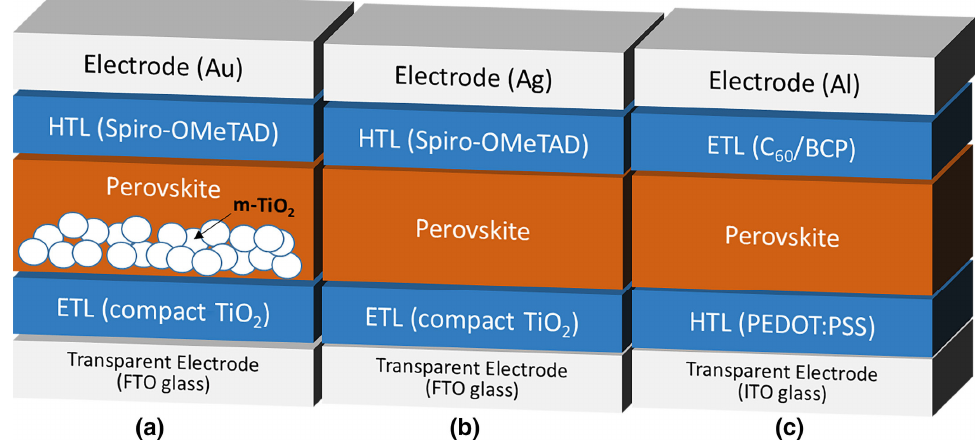
Figure 8. Device architectures for ( a ) mesoporous perovskite solar cell of the normal structure, ( b ) normal structure planar heterojunction perovskite solar cell and ( c ) inverted planar heterojunction perovskite solar cell [49]. (Reproduced from Ref. [49], 10.1002/eem2.12035, with permission.)